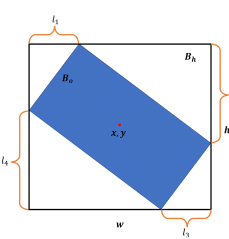
Figure 7. First, determine black box B h (x, y, w, and h) of the object’s border, and the red dot represents the coordinates of the object center point. Then calculate the offset of each corner point( β 1 , β 2 , β 3 and β 4 ) in the HBB to describe the blue box, B o , of the